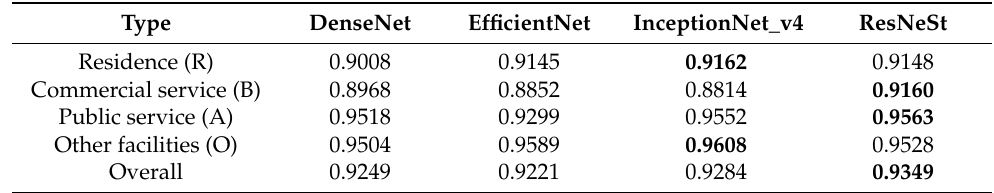
Figure 10. The area under the ROC curve (AUC) of all the trained networks evaluated by our test images, including DenseNet ( a ), EfficientNet ( b ), InceptionNet_v4 ( c ), and ResNeSt ( d ). The red line R represents the AUC of residence, the blue line B represents the AUC of commercial service, the yellow line A represents the AUC of public service, and the purple line O represents the AUC of other facilities. Table 5. Multi-label classification performance of all the trained